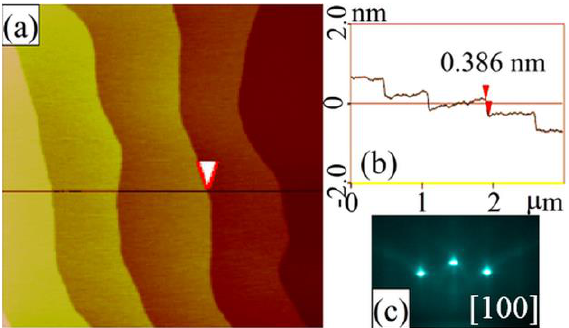
Figure 3. ( a ) Topographic AFM image, ( b ) the line scan profiles, and ( c ) the RHEED pattern of the substrate from ( a ) for a (001) NdGaO 3 substrate chemically etched for 2 min (m-BHF solution, pH = 4.5), followed by annealing for 2 h at 1000 °C in O 2 flow (200 L/h). AFM scans size: 3 × 3 μm 2 (from Ref. [29]).